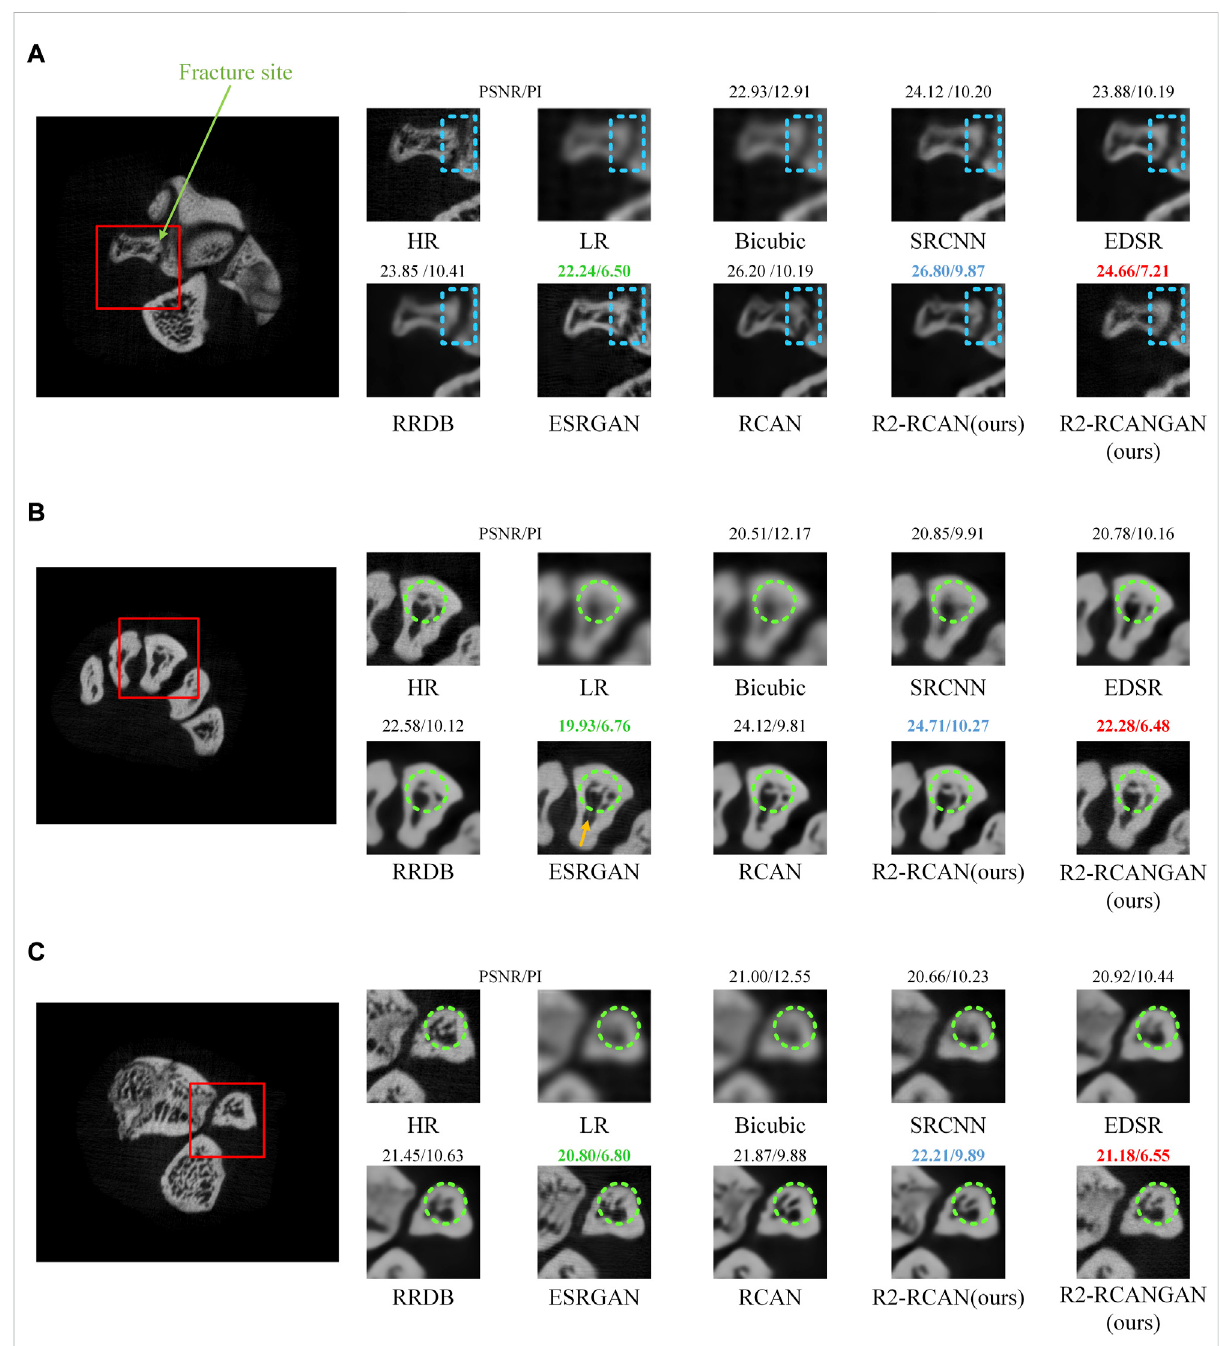
FIGURE 7 Visual comparison of different methods. R2-RCAN (blue) has the highest reconstruction accuracy, but loses a lot of image texture. ESRGAN (green)hadthebestperceptualquality,butshowedmanyerroneoustexturesandtheworstreconstructionaccuracy.R2-RCANGAN(red)hasagood performance in both reconstruction accuracy and perceptual quality. (A) Sample of the fracture site. (B,C) Sample of the trabeculae